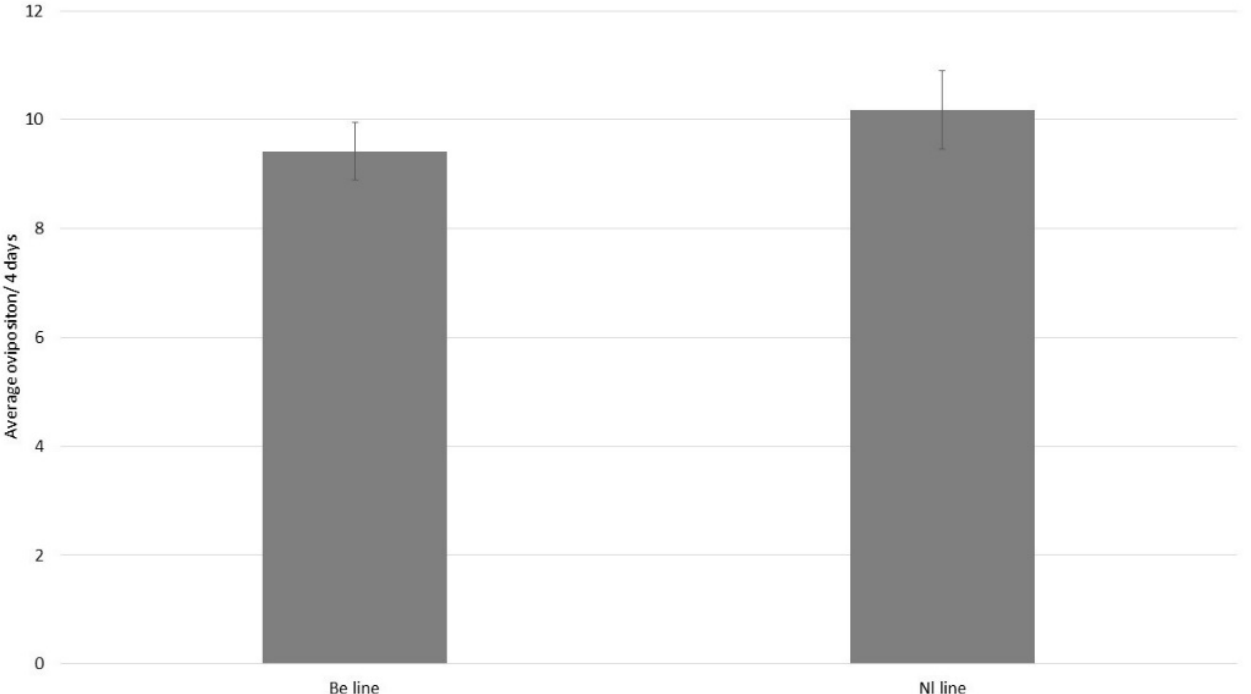
Figure 1. Average of the total oviposition for four days (mean ± SE) for P. ubiquitus either collected in Belgium (Be line) or The Netherlands (Nl line) on a tomato leaf with the addition of T. angustifolia pollen. There were no significant differences between the two lines (GLM, χ 2 = 0.34; p = 0.56).